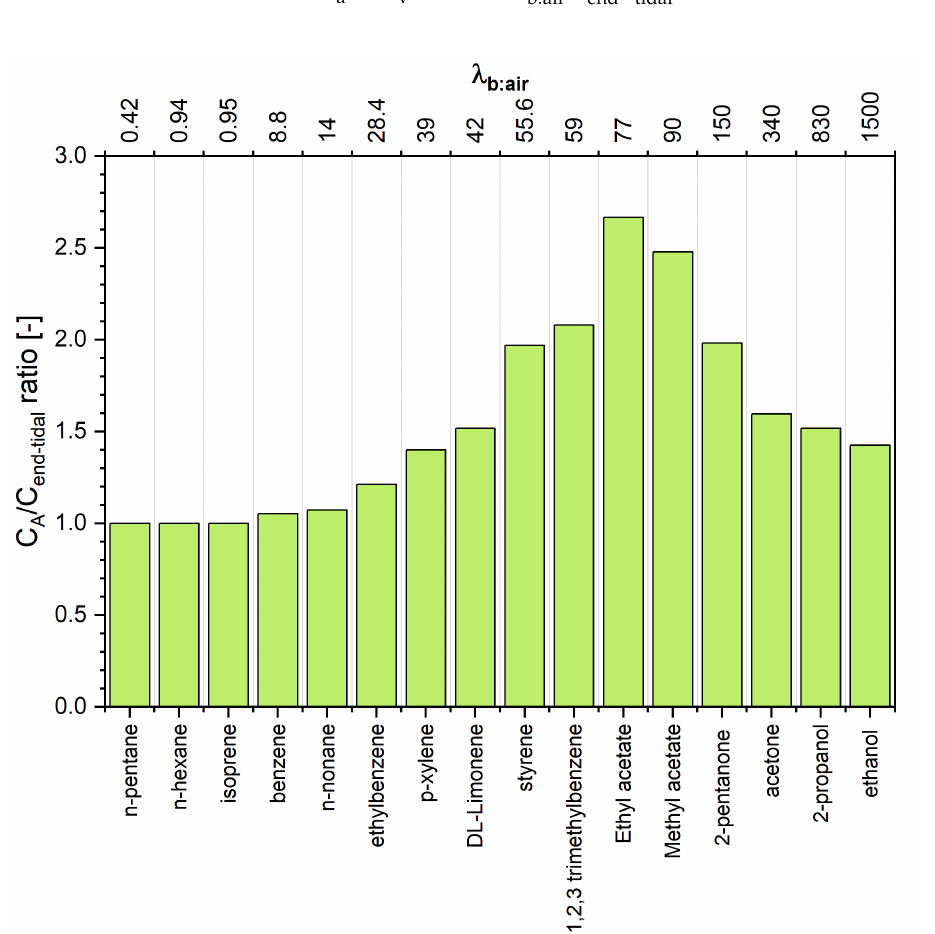
Figure 3. Concentration ratio between alveolar and end-tidal air C A / C end scrutiny. Compounds are ordered with respect to increasing blood:air partition coefficient λ b:air